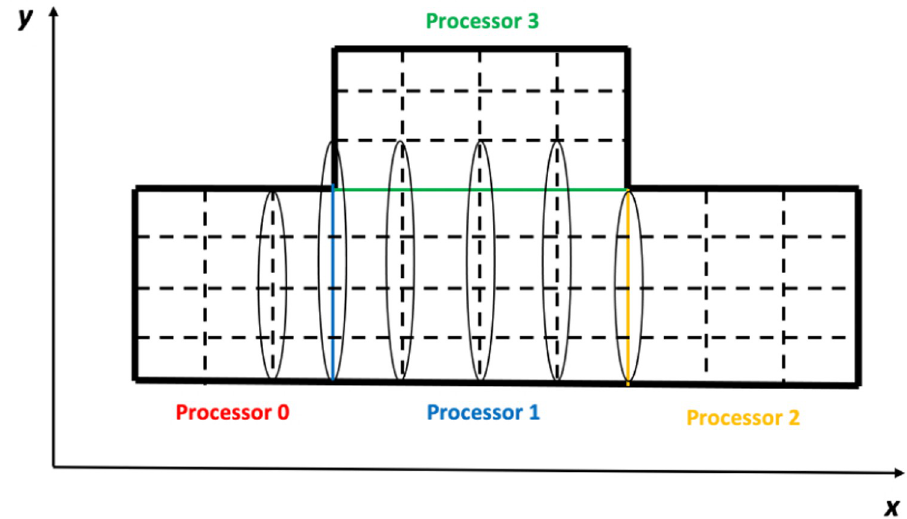
Fig 8. For the discretization pattern “xxlap”, the positions of the DVs of the AEs on the subdomain of Processor 1 are surrounded by six circles.